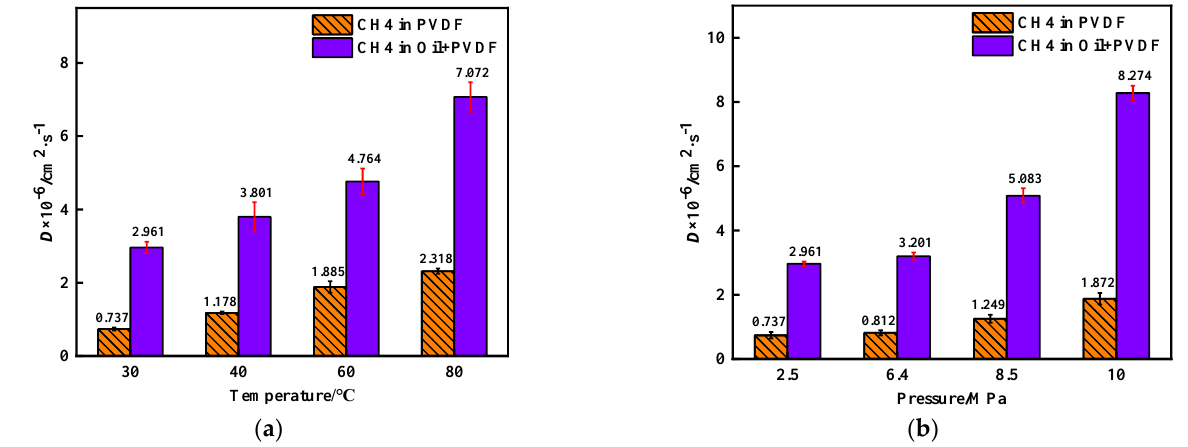
Figure 7. MSD curves of CH 4 in PVDF containing crude oil at 2.5 MPa.